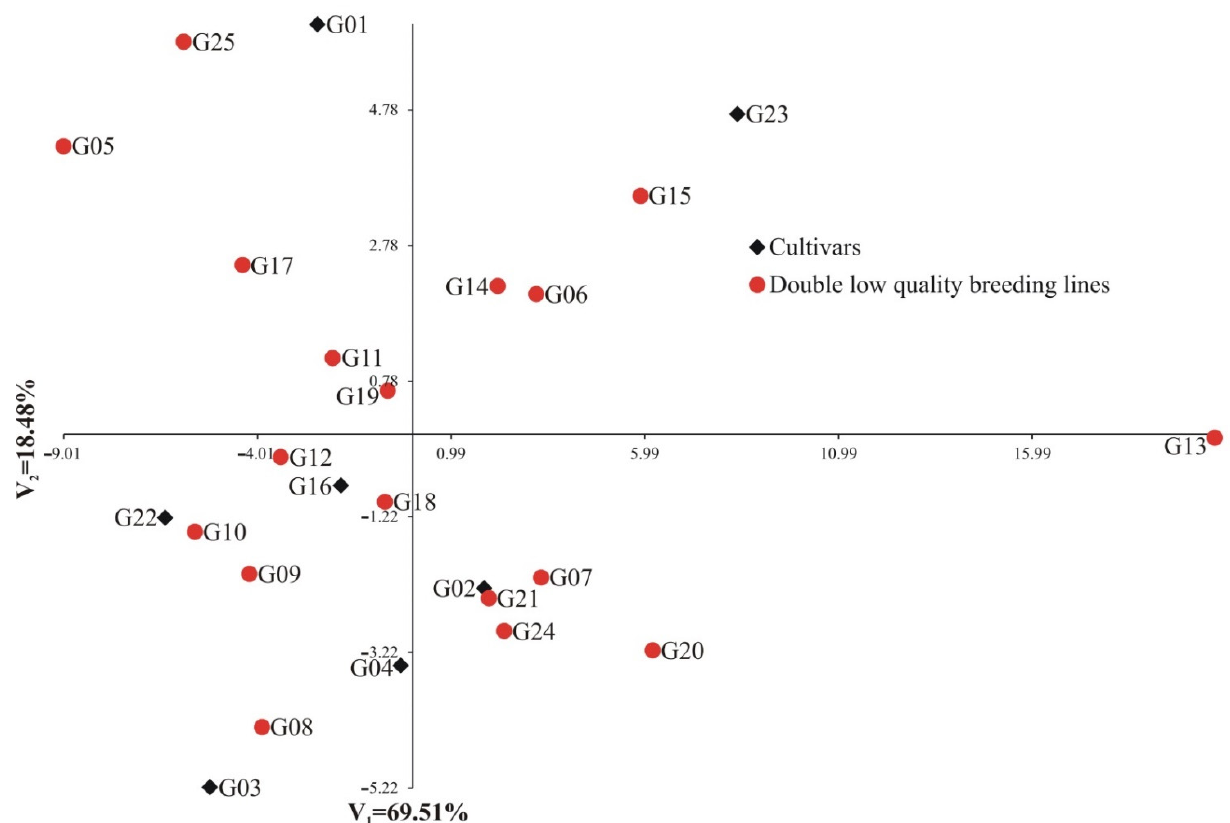
Figure 8. Distribution of 25 genotypes of winter oilseed rape ( Brassica napus L.) in the space of the first two canonical variates in Ł agiewniki 2015.